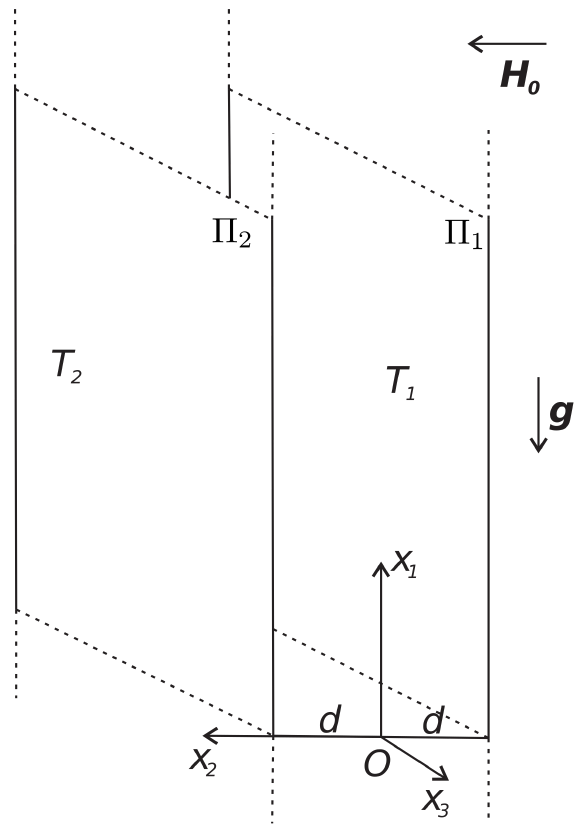
Figure 1. Physical configuration and coordinate system ( T 2 > T 1 )